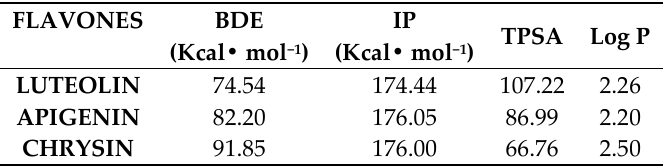
Table 3. Binding dissociation enthalpy ( BDE), ionization potential (IP), topological polar surface area (TPSA), and partition coefficient octanol/water (log P) of